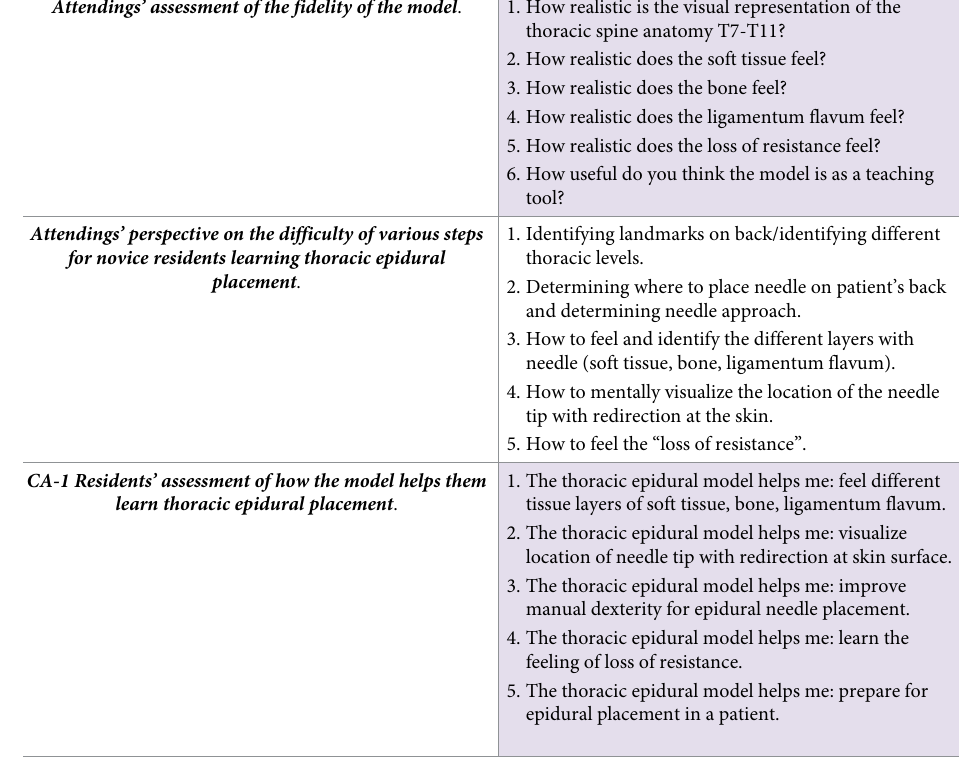
Table 1. Outline of survey questions. Attendings’ assessment of the fidelity of the model .